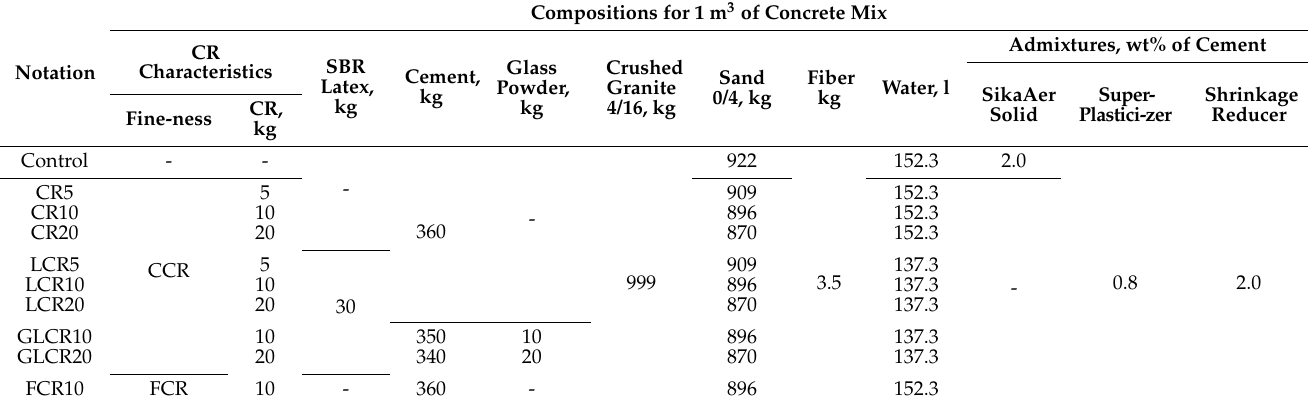
Table 2. Proportions of concrete